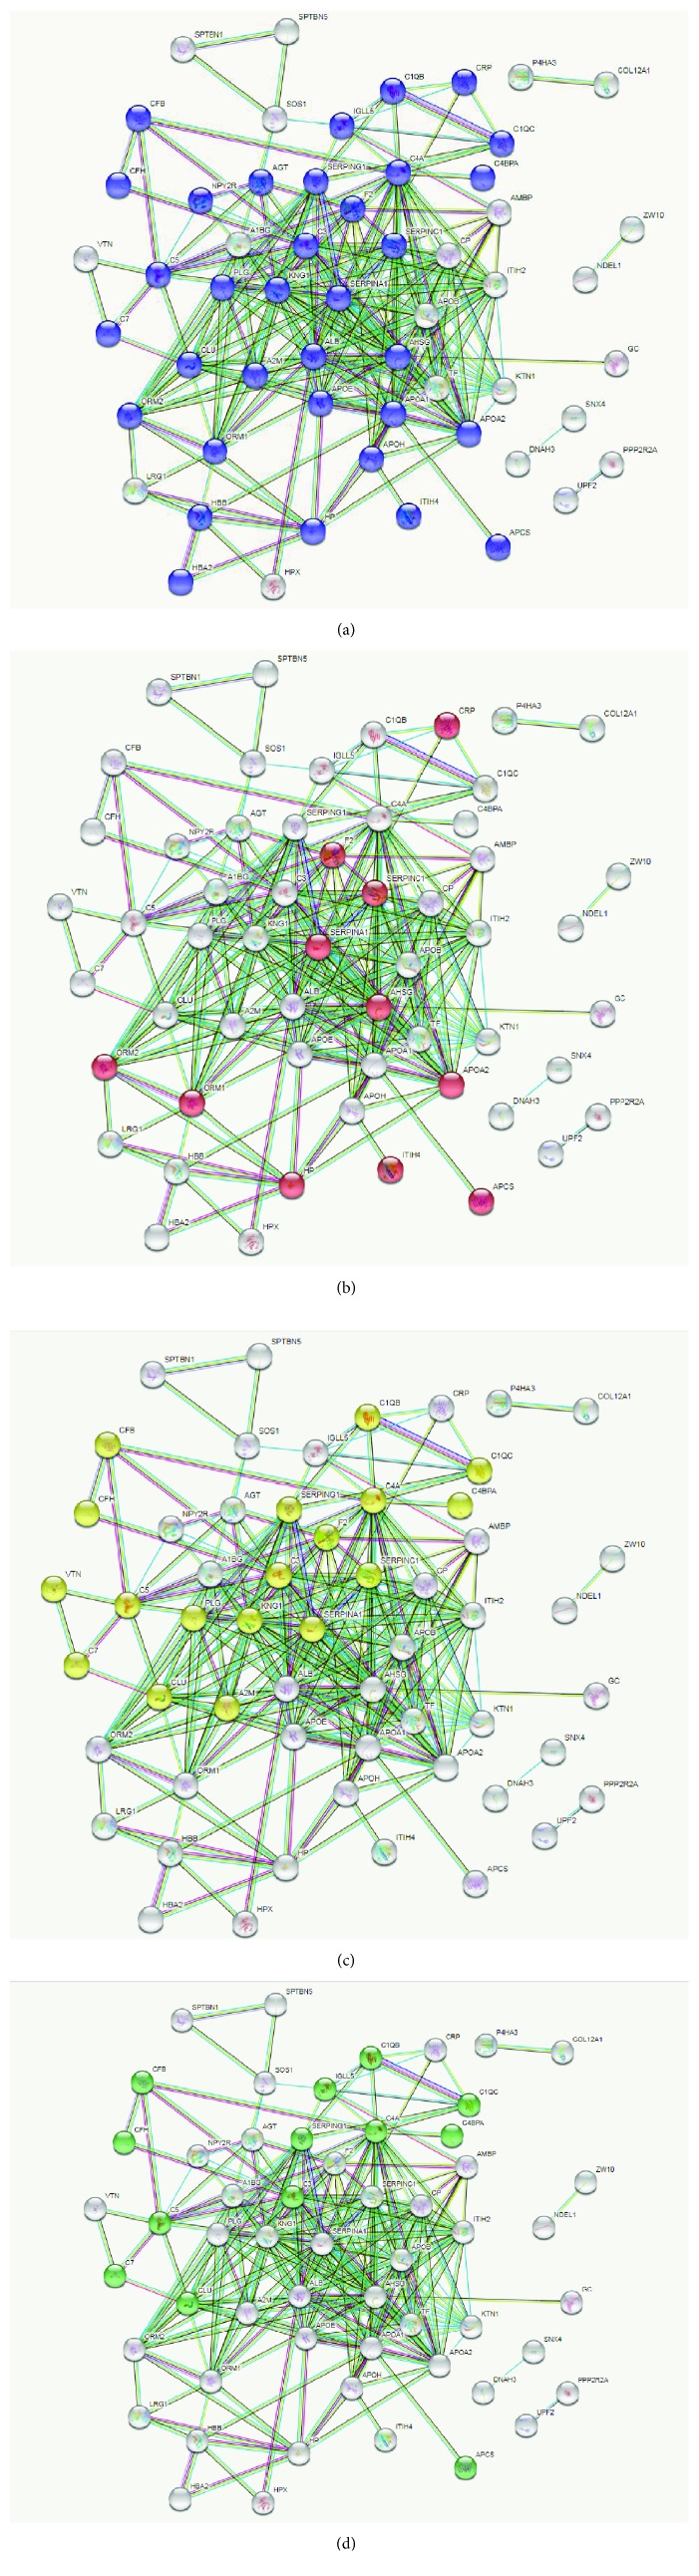
Network of interactions among the upregulated proteins in chemoresistant breast cancer identified by STRING software. (a) Proteins identified in the representative “response to oxidative stress” network are in blue. (b) Proteins identified in the representative “acute inflammatory response” network are in red. (c) Proteins identified in the representative “complement and coagulation cascades” network are in yellow. (d) Proteins identified in the representative “innate immune system” network are in green. The networks were generated with high interaction score > 0.9.